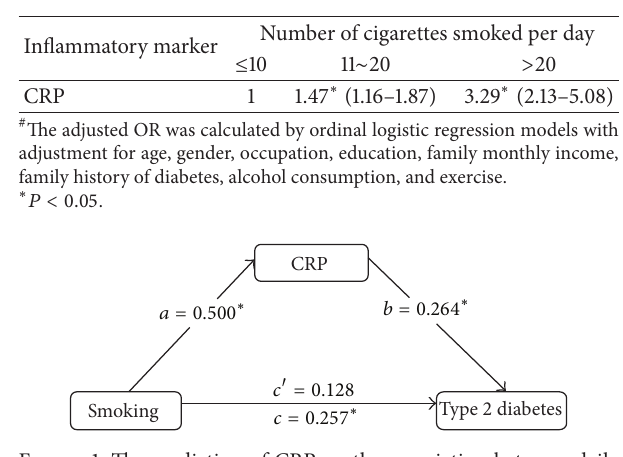
Table 2: The association between number of cigarettes smoked per day and CRP in 984 Chinese current smokers (OR; 95% CI) # .